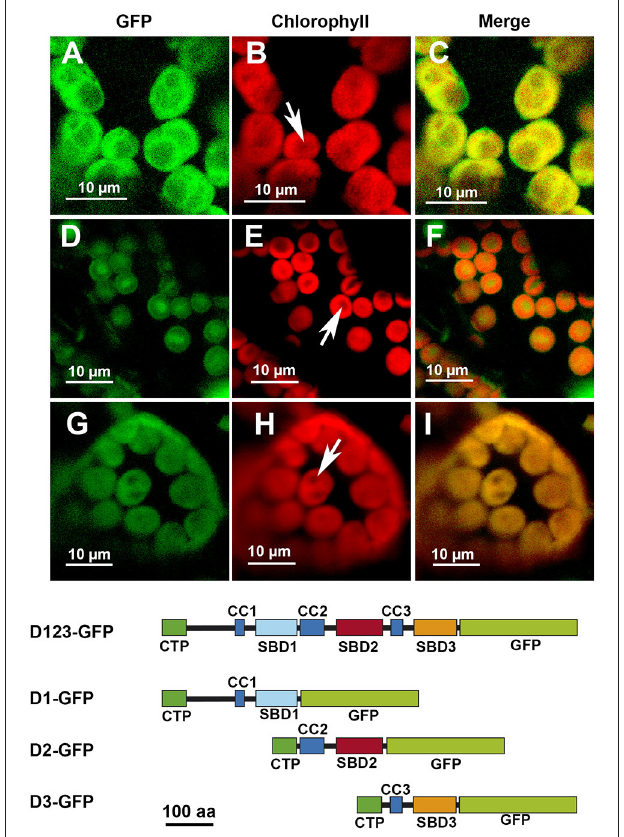
FIGURE 4 | Localization of different truncated versions of AtSS3 fused to GFP in N. benthamiana chloroplasts. D1-GFP: (A–C) . D2-GFP: (D–F) . D3-GFP: (G–I) . GFP column: fluorescence of the GFP marker. Chlorophyll column: autofluorescence of the chlorophyll. Merge column: merged images of previous columns. Bottom: structures of the constructs fused to GFP. D1-GFP: N-terminal region of AtSS3 without D2 and D3 domains fused to GFP. D2-GFP: N-terminal region of AtSS3 without D1 and D2 domains fused to GFP. D2-GFP: N-terminal region of AtSS3 without D1 and D2 domains fused to GFP. The white arrows indicate the presence of a starch granule.